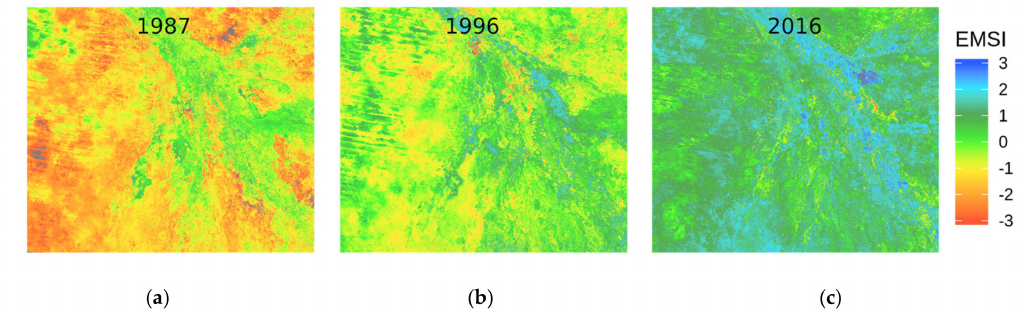
Figure 6. Select years for the March Landsat EMSI ( a ) during drought-like conditions the higher elevation uplands appear deeply stressed in the western portion with some grass fires apparent on the south eastern edges (reds), but in the lower river-fed Okavango delta conditions are near normal (stable light green), using the state descriptions in Table 2, for the year 1987, ( b ) degraded and stressed upland conditions with a robust lowland delta in 1996, and ( c ) a robust and exceptional year for both upland and lowlands in 2016. All panels in the same extraction area over the Okavango Delta, Botswana, Africa. Banding that appears on the left side of the images are caused by slope-aspect and topographic variation caused by ancient dune